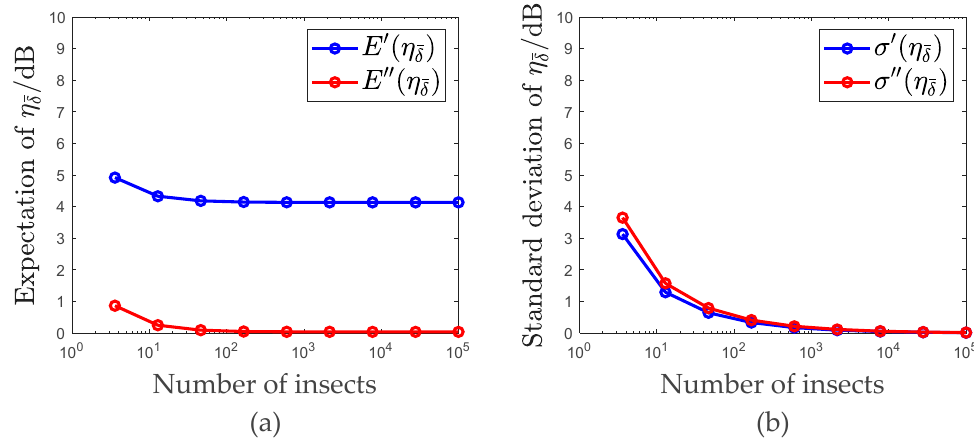
Figure 8. Comparison of the simulation results of 𝜂 (cid:3083)(cid:3365) : ( a ) expectation of 𝜂 (cid:3083)(cid:3365) ; ( b ) standard deviation of 𝜂 (cid:3083)(cid:3365) .